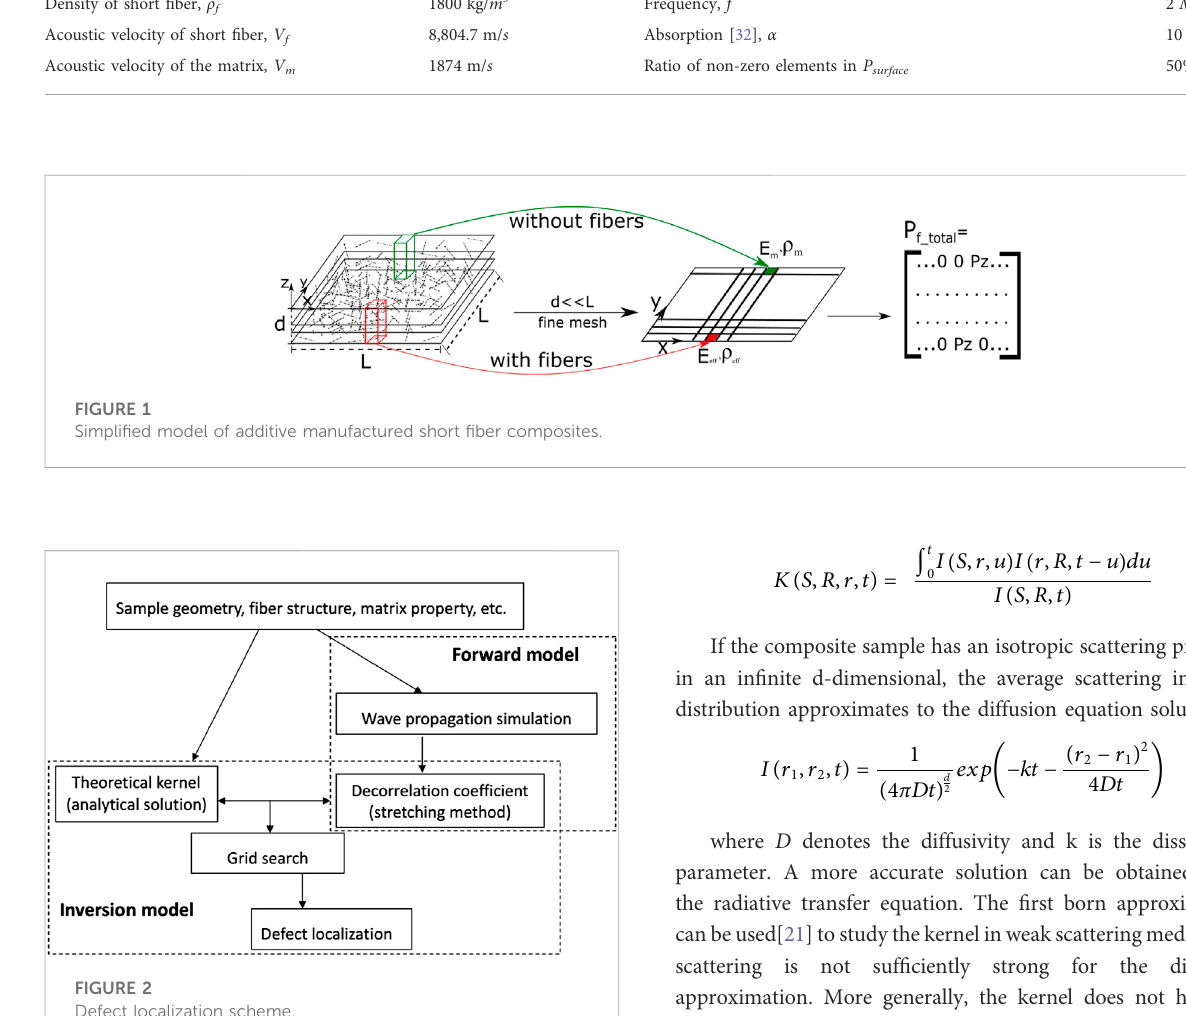
FIGURE 2 Defect localization